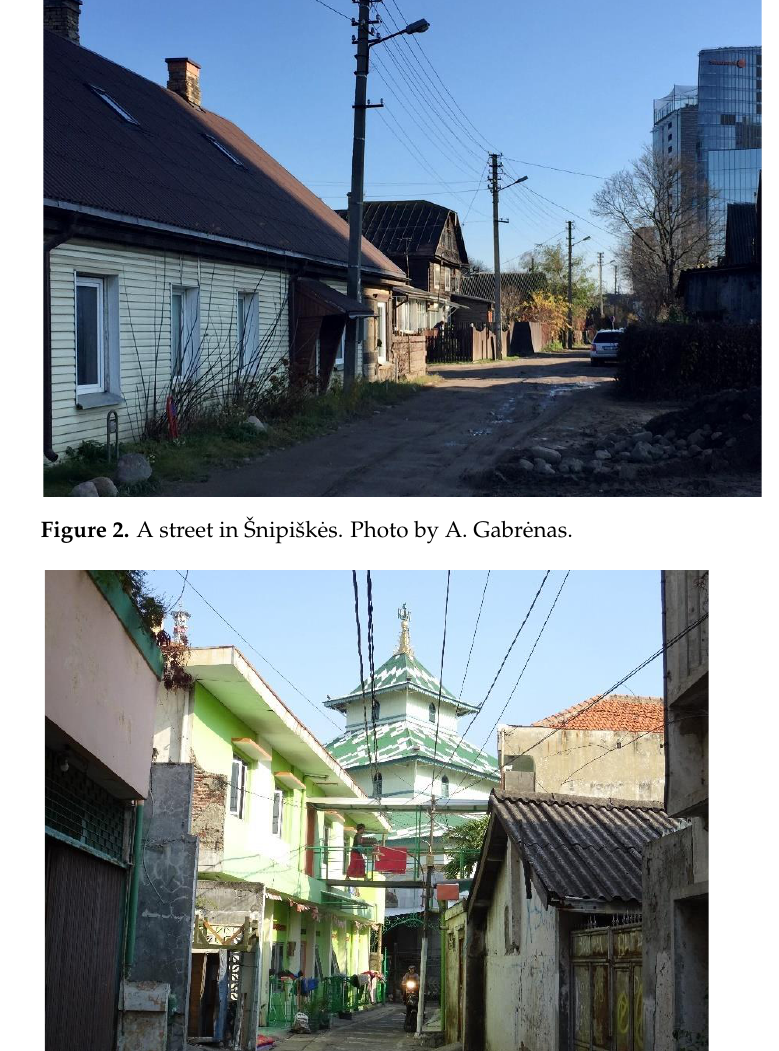
Figure 3. A kampung in Semarang, Indonesia. Photo by A. Samalavičius.